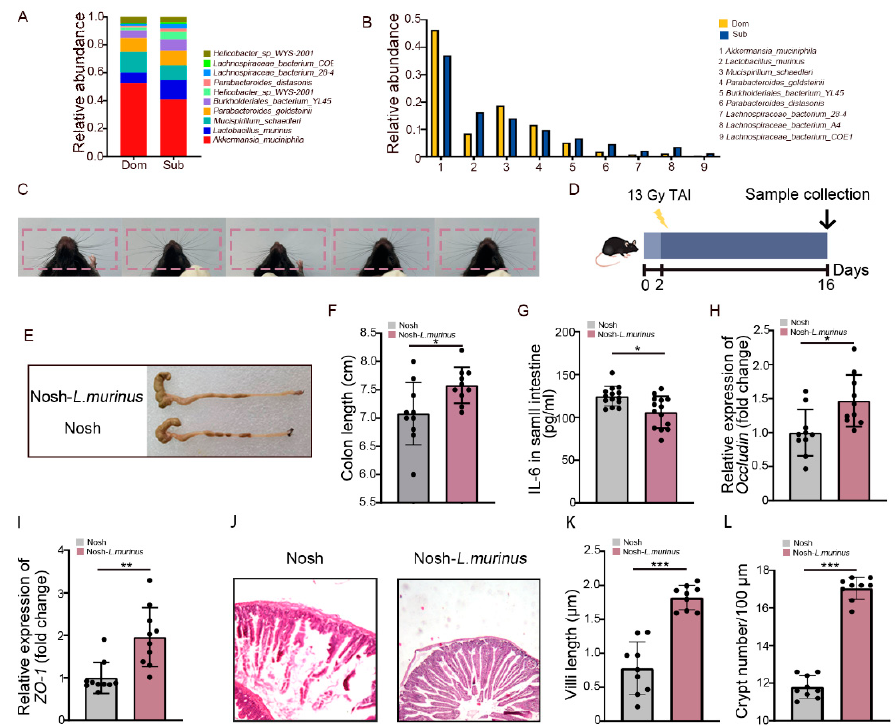
Figure 5. L. murinus alleviated intestinal radiation toxicity in mice without social hierarchy. ( A , B ) The relative abundances of the top 10 different strains of bacteria at the genus level in Dom and Sub mice after exposure to 13 Gy TAI. ( C ) Whiskers of five random mice in a group. ( D ) Experimental protocol. ( E ) Photographs of dissected colons. ( F ) Statistical comparison of colon length between the two groups. ( G ) Protein levels of IL-6 in the small intestine were measured by ELISA. ( H , I ) The mRNA expression levels of occludin and ZO-1 in small intestinal tissues from the two groups were examined by qRT-PCR. ( J ) The morphology of the small intestine was revealed by H&E staining. ( K ) Small intestinal villi length. ( L ) Numbers of small intestinal crypts. Statistically significant differences are indicated: Student’s t test, n = 10 per group, * p < 0.05, ** p < 0.01 and *** p < 0.001.